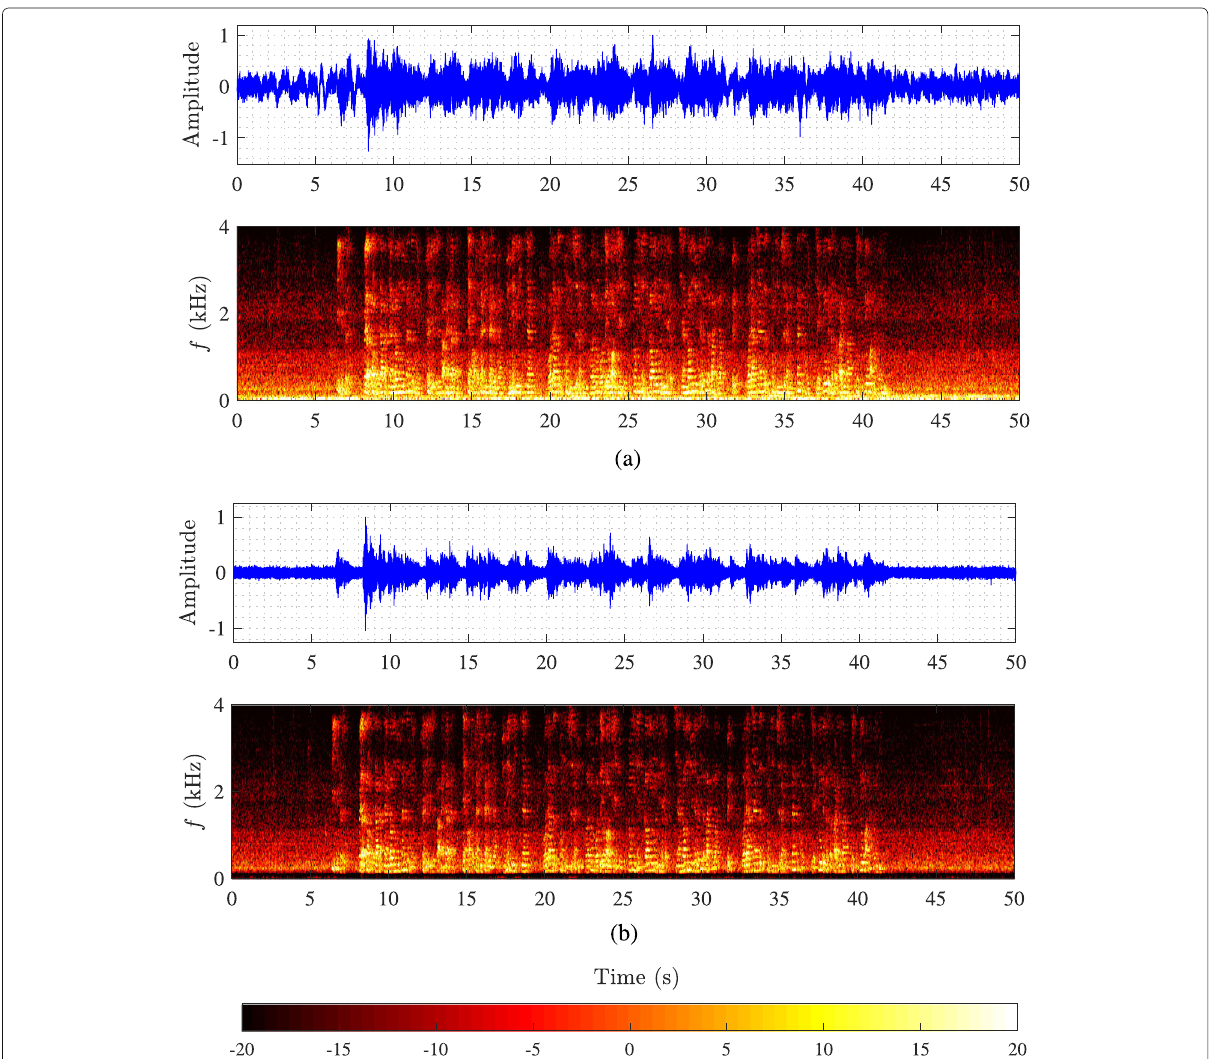
Fig. 12 Performance in a conference room: a signal observed at the 1st sensor and its spectrogram and b output of the 1st-order DMA beamformer and its